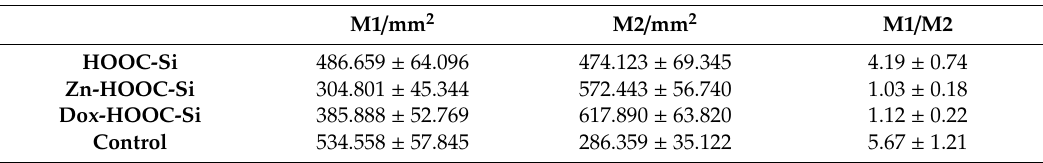
Table 8. Statistical results ( p values) after pairwise comparisons. Bold numbers mean significance at p < 0.05.